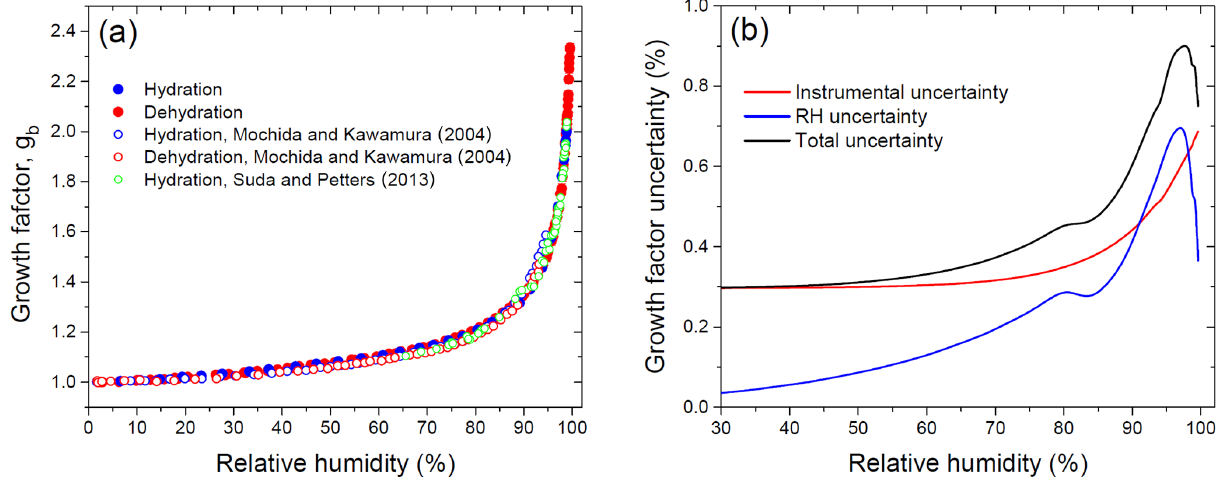
Figure 9. Growth factors observed in the hydration and dehydration experiments for the preconditioned glucose aerosol particles with D b, H&D , min = 99 . 6nm in comparison with literature data (a) and relative growth factor uncertainty due to instrumental and RH errors (b)